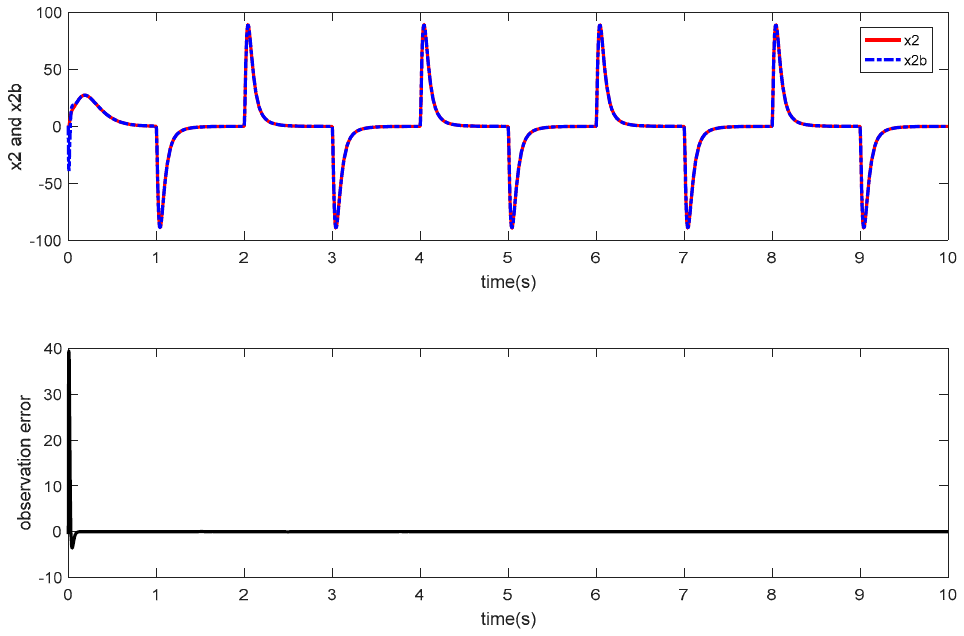
Figure 12. Comparison of the actual and estimated values of the system input.